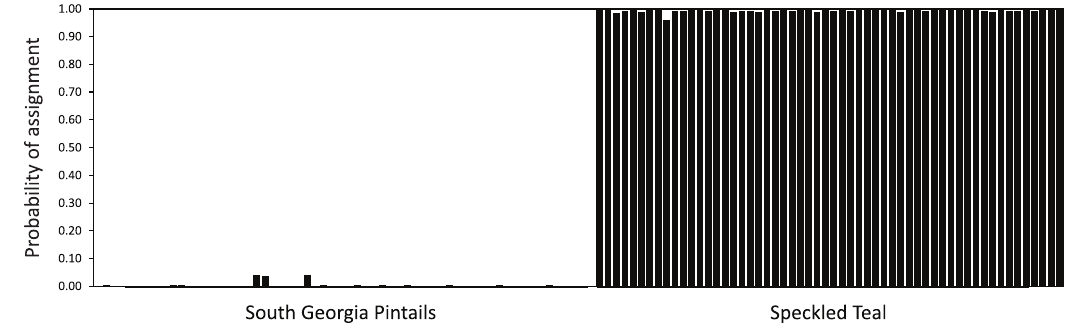
Figure 3. Assignment probabilities for South Georgia pintails and speckled teal for K = 2 populations.